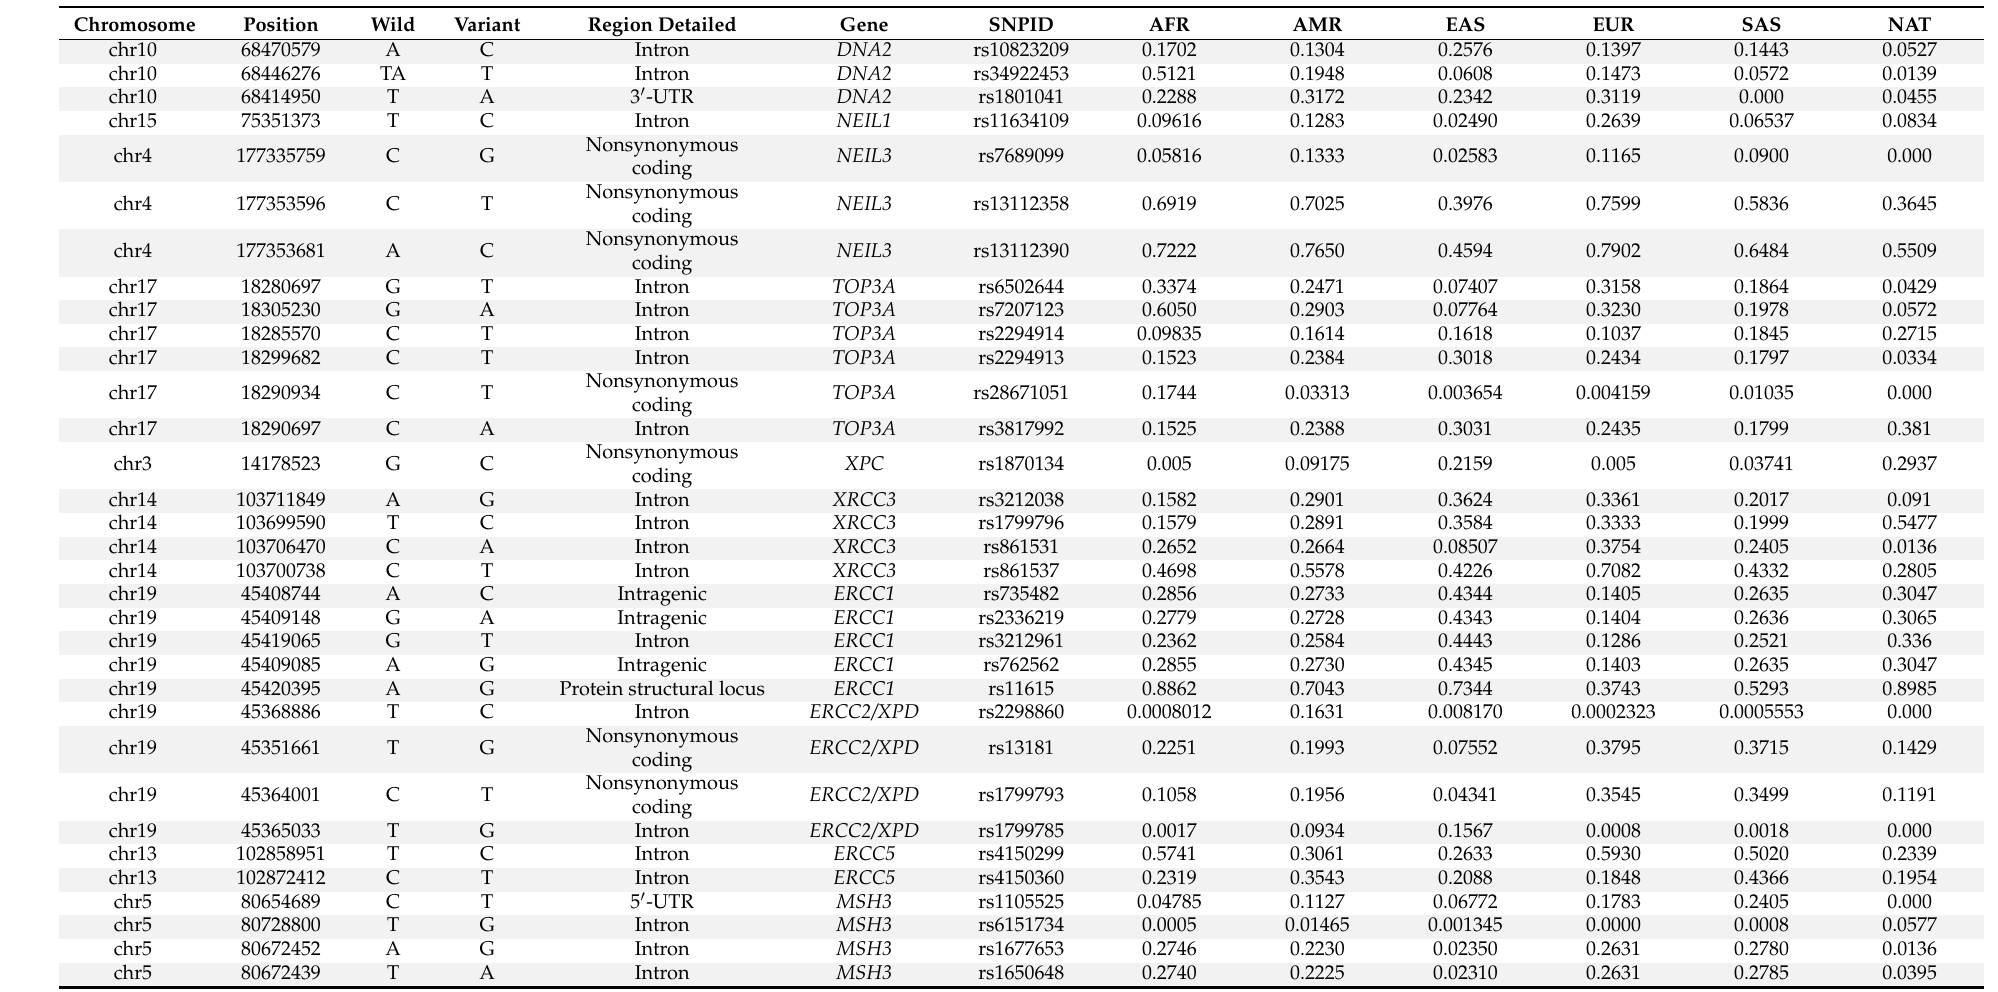
Table 1. Allele frequencies of the variants investigated in the Amerindian individuals (NAT) and continental populations (African (AFR), American population (AMR), East Asian (EAS), European (EUR), and South Asian (SAS)) described in the gnomAD